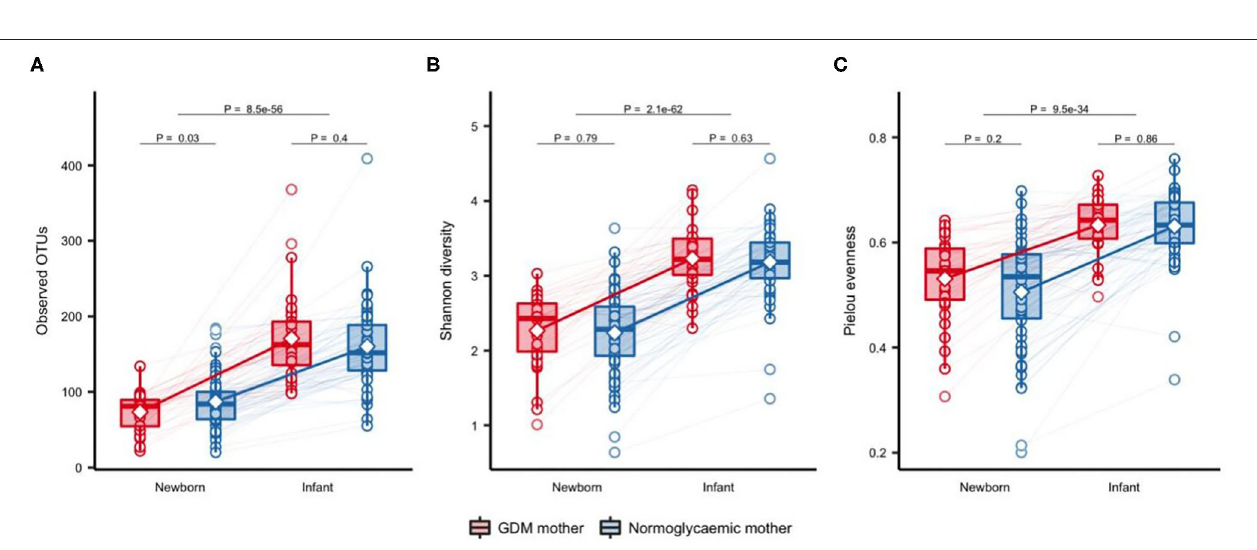
FIGURE 2 | Change in alpha diversity of gut microbiota from one week of life to an average of 9 months of life. Observed OTUs (A) , Shannon’s diversity (B) , and Pielou’s evenness (C) , respectively, in offspring of mothers with GDM ( n = 32) and mothers with normal gestational glucose regulation ( n = 64) at one week of life and at ∼ 9 months of life. Samples were rarefied to an equal sequencing depth of 10,000 reads. Boxes represent interquartile range (IQR), with the inside line representing the median. Whiskers represent values within 1.5 × IQR of the first and third quartiles. Circles represent individual samples with lines connecting samples from the same individual. Differences between children born to mothers with GDM and children born to normoglycaemic mothers within each time point were tested using Students t -test. Difference between time points in all children was tested using a paired t -test.